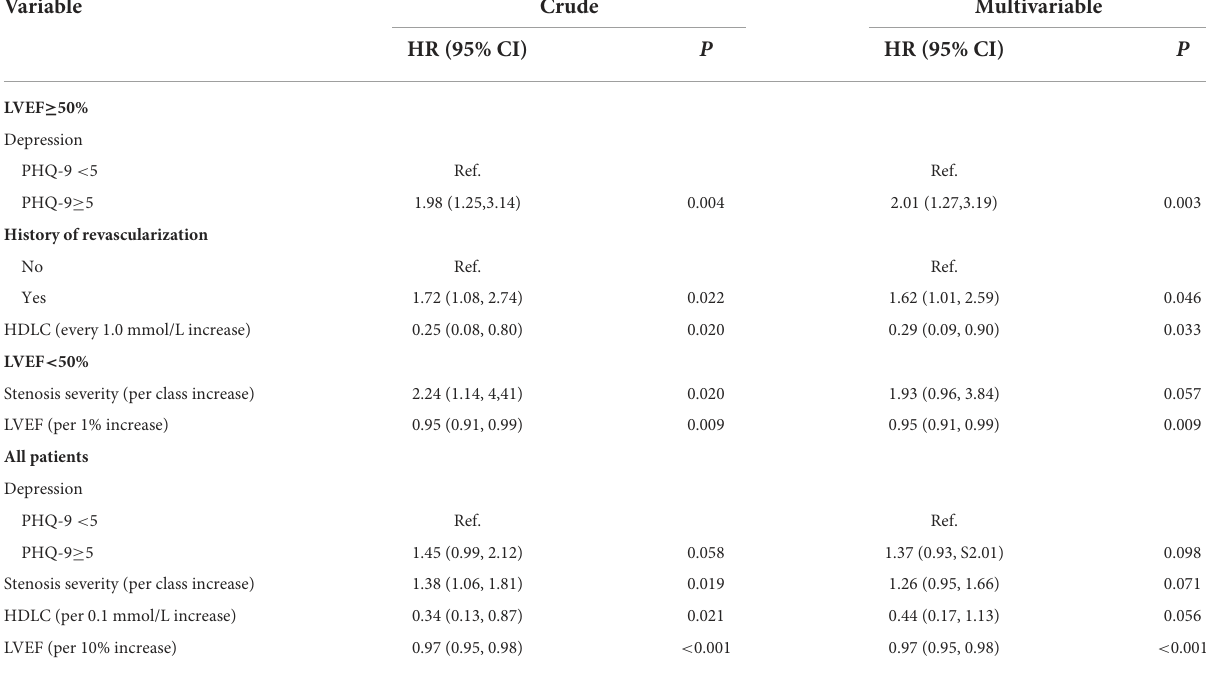
TABLE 3 Predictors for MACE in patients with different systolic function using Cox regression models † .